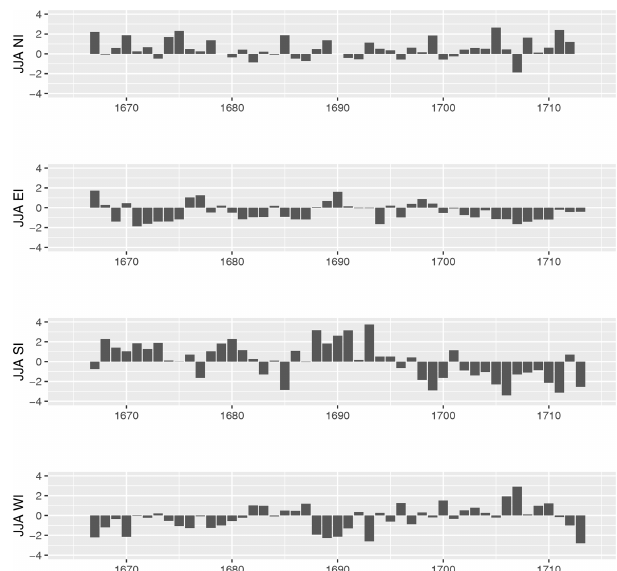
Figure A6. Standardized JJA DI time series for the LMM (1665– 1713) with respect to the mean of the reference period of 1981– 2010.